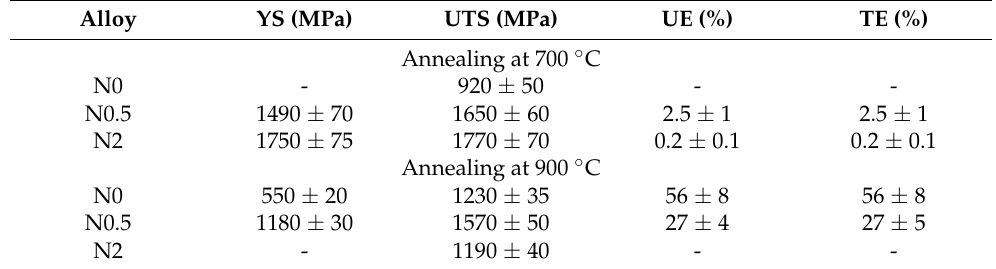
Table 6. Impact toughness of the Fe 40-x Mn 40 Cr 10 Co 10 N x alloys after rolling and annealing at 700 °C and 900 °C obtained at room and cryogenic temperatures.